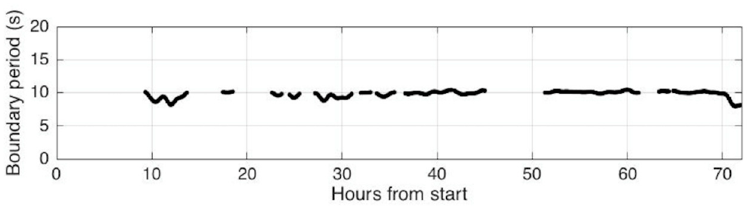
Figure 7. The boundary period plotted vs. time. Start time: 12:00 am, 29 January 2018.